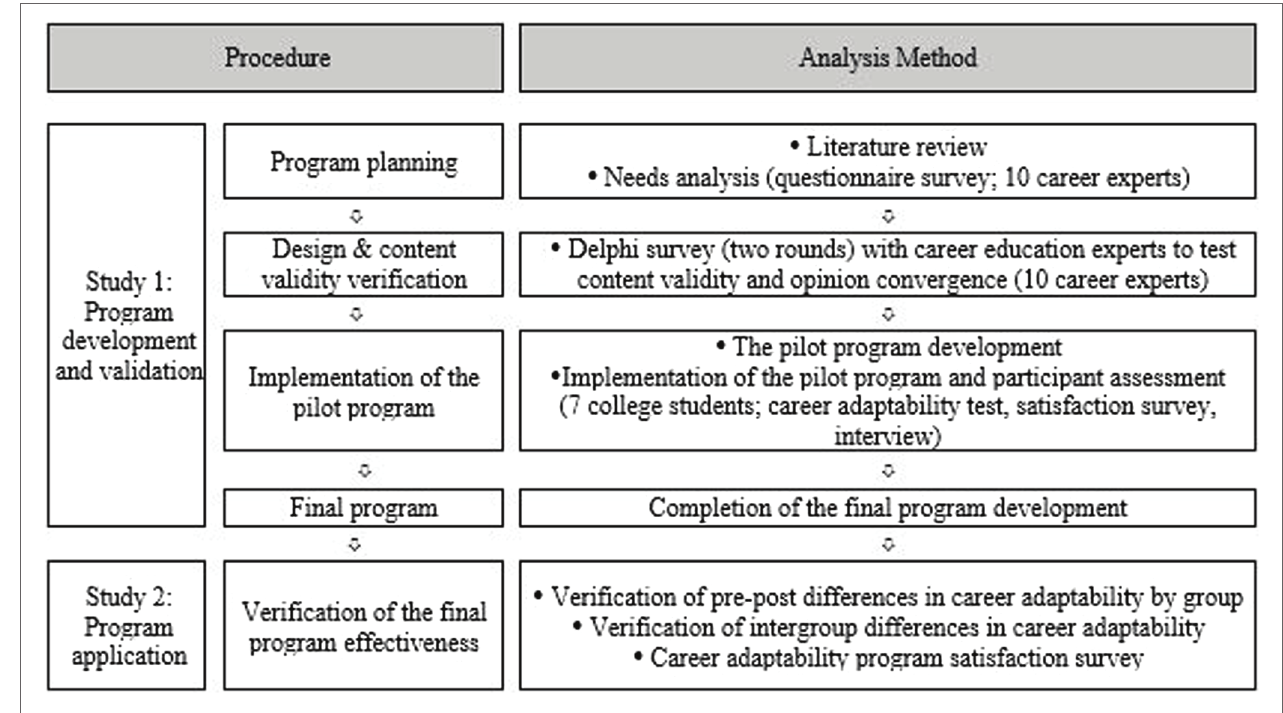
FIGURE 1 | Research procedure and